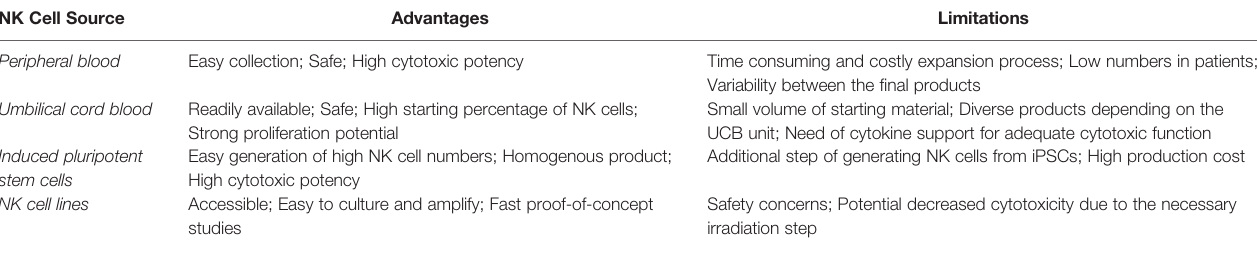
TABLE 1 | Advantages and limitations of NK cell